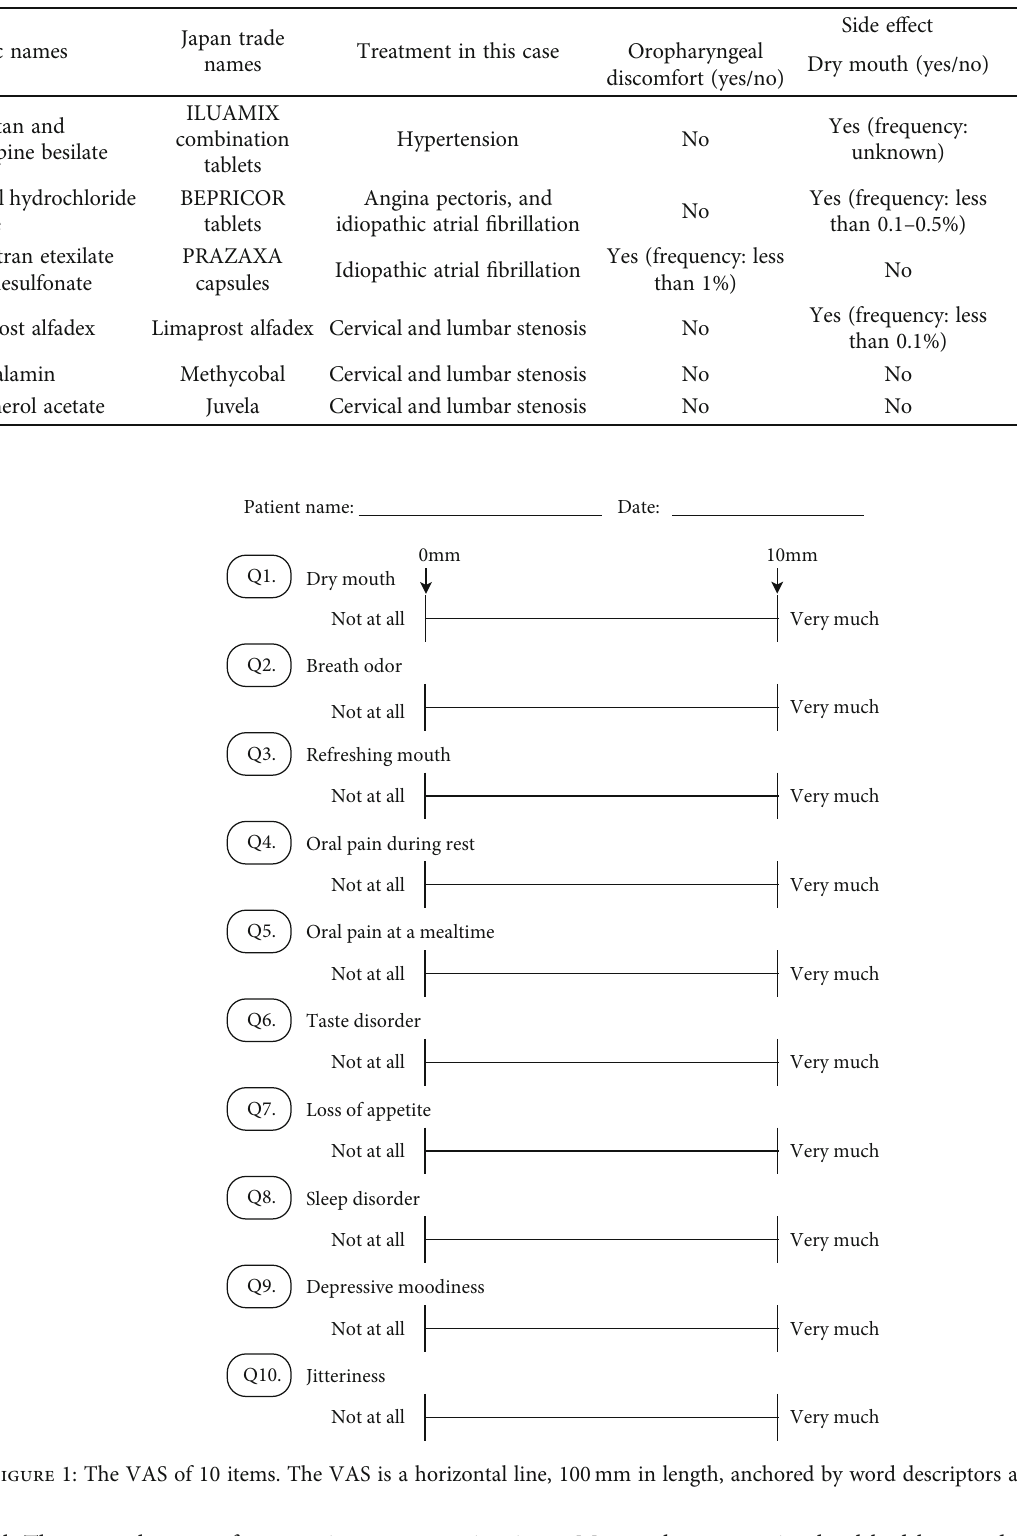
Table 1: Medications that the patient was taking at the time of the fi rst visit.